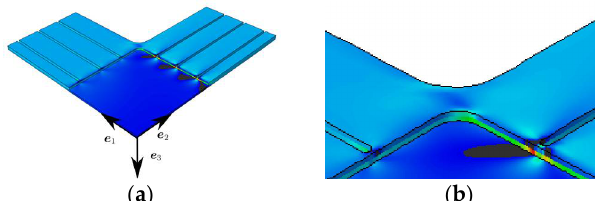
Figure 4. ( a ) FE results for uniaxial load in (cid:2187) (cid:2869) -direction at a displacement of the specimen arms of 0.2 mm, normal strain (cid:2013) (cid:2870)(cid:2870) ( b ) Detail from ( a